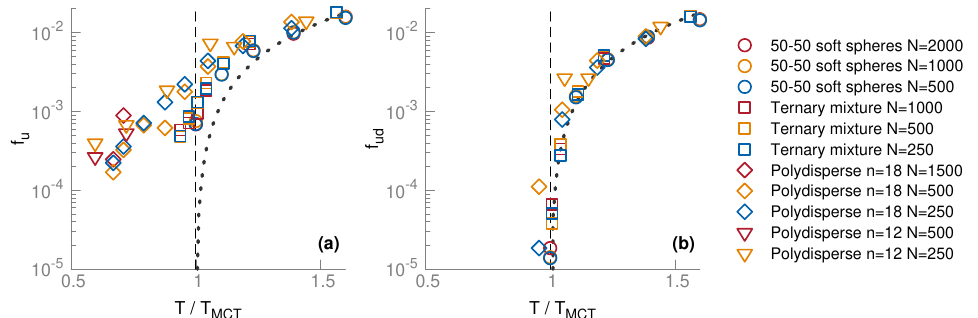
Figure 11: (a) Fraction of unstable modes f points obtained from W -minimizations in all studied models except the network- forming liquid. (b) Same as (a) but for the fraction of delocalized unstable modes f . The correspodning system size N is indicated in the legend. In both panels, the ud dotted line indicates the approximate master Eq. (10) for delocalized unstable modes as shown in Fig. 1(b). The vertical dashed lines indicates the location of the MCT crossover